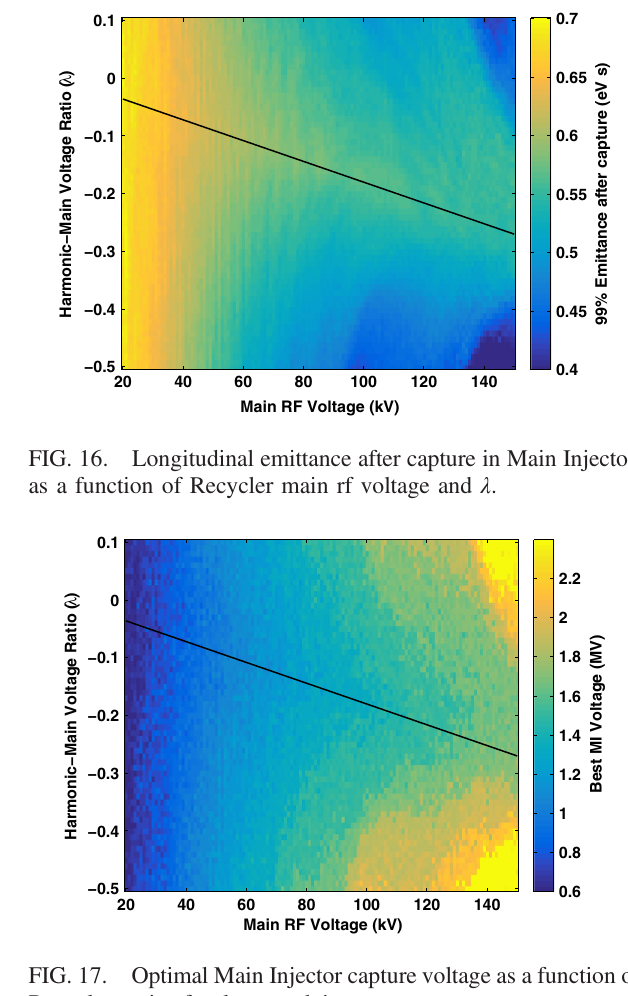
FIG. 17. Optimal Main Injector capture voltage as a function of Recycler main rf voltage and λ .